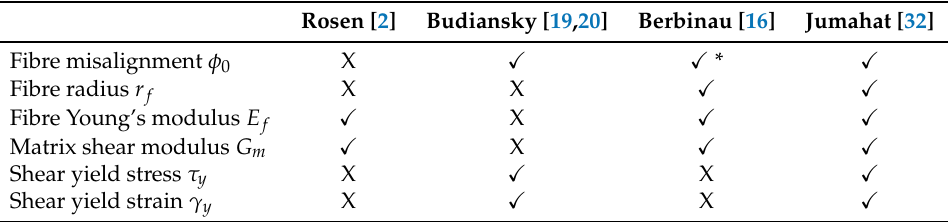
Table 1. Comparison of input parameters for different analytical models for compressive strength prediction of FRP UD laminates. Rosen [2] Budiansky [19,20] Berbinau [16] Jumahat [32] Fibre misalignment φ